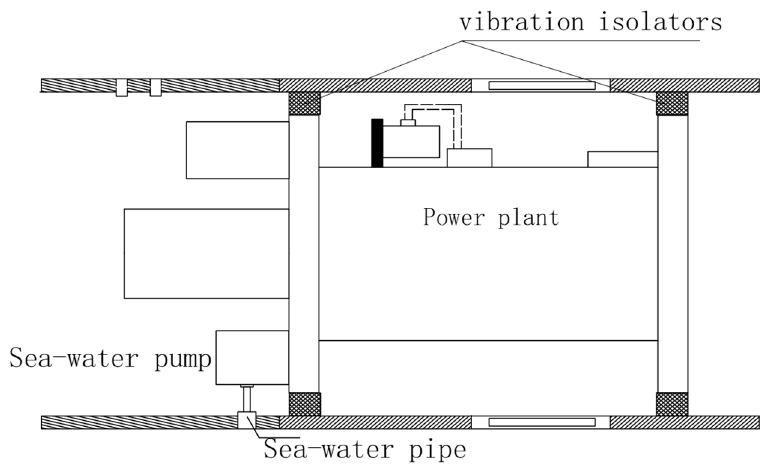
Figure 1. The position of the sea-water pipe in the power system.